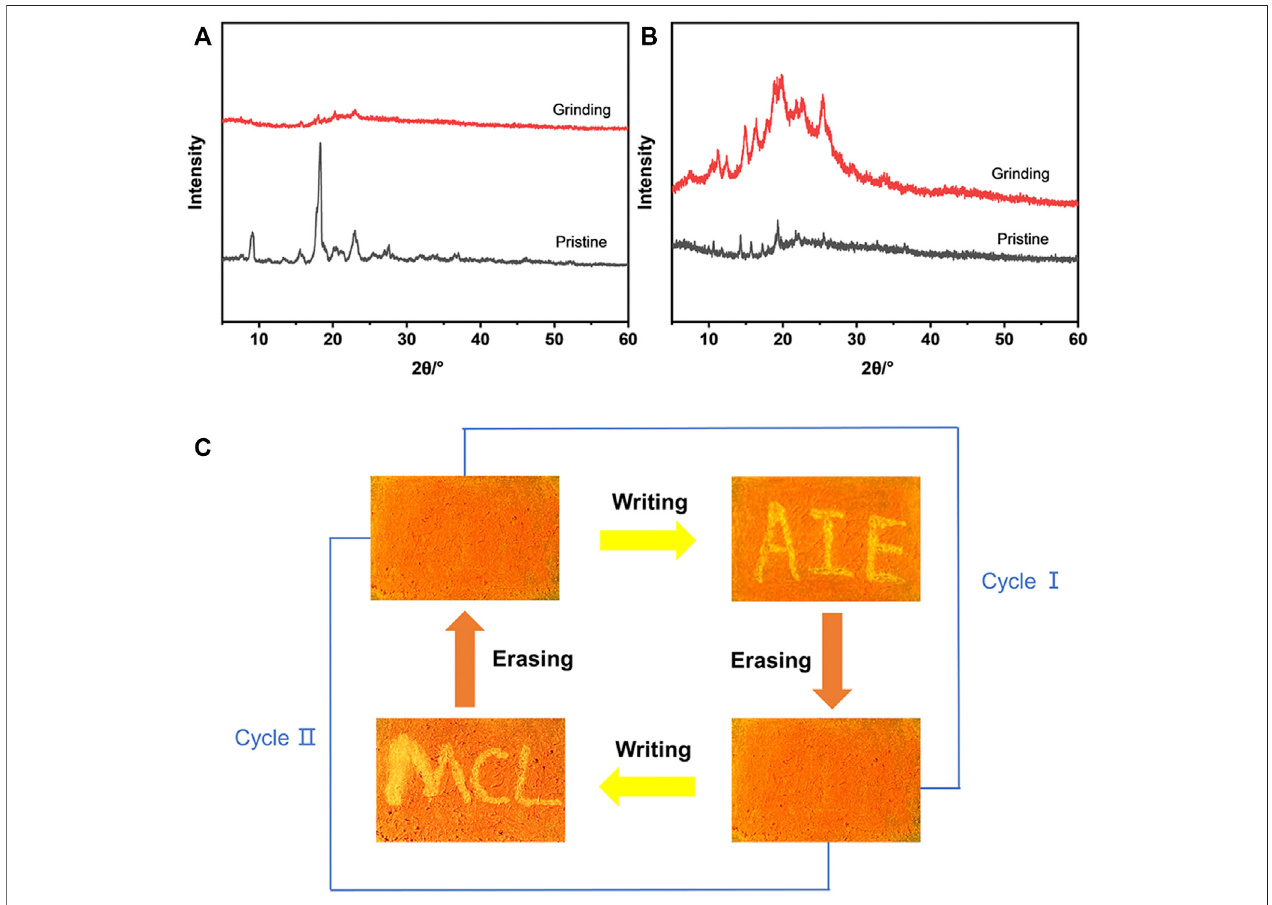
FIGURE 7 | (A) PXRD patterns of compound MOX2 in different states: pristine (black line), grinding (red line). (B) PXRD patterns of compound MOX4 in different states: pristine (black line), grinding (red line). (C) A reversible data recording device of MOX2 based on its mechanochromic phosphorescence.